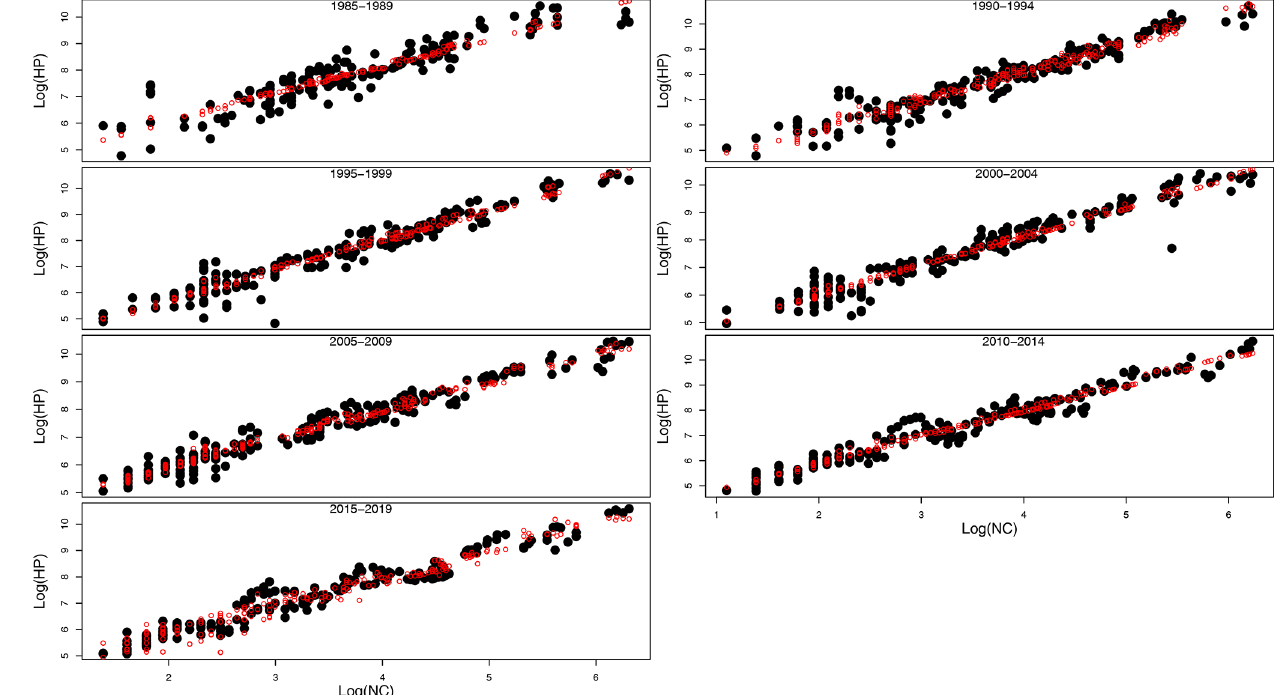
Figure 2. Real HP (honey production) values (black solid dots) and predicted HP values (red open circles) from GLMs plotted against real NC values in logarithmic scale for the seven sub-series of years.